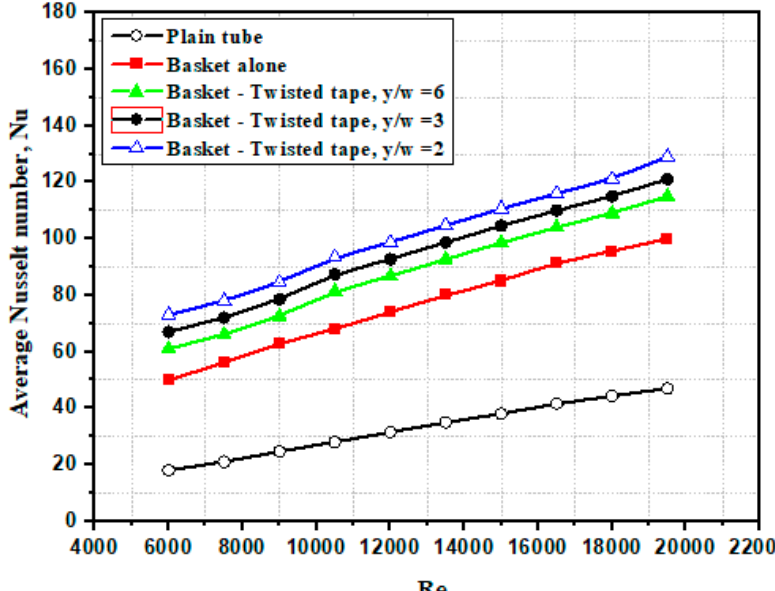
Figure 6. Difference of Nusselt number and Re number for heat exchanger trim by basket alone and combined basket–twisted tape inserts.